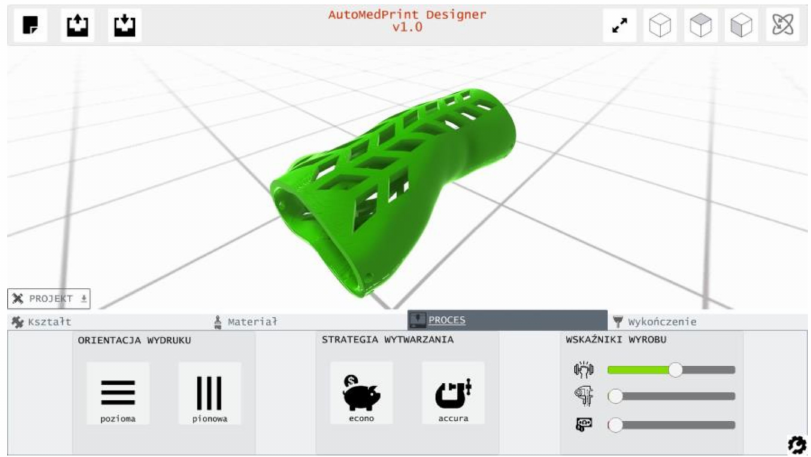
Figure 20. Product configurator—part of the AutoMedPrint system, user interface for the strategy and orientation selection visible below the orthosis